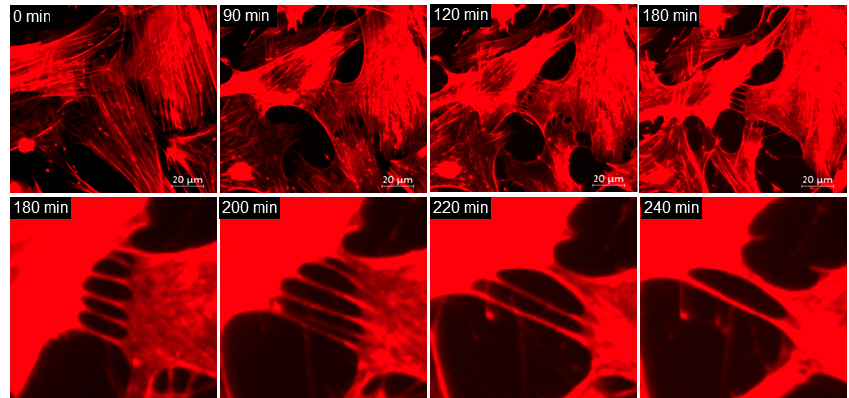
Figure 6. Still images of NTM cells taken from the movie shown in Supplemental Figure S4A,B. Time points shown are 0, 90, 120, 180, 200, 220, and 240 min. Over the course of 60 min, six TNTs undergo lateral fusion so that only two TNTs remain at the final time point. Scale bar = 20 µ